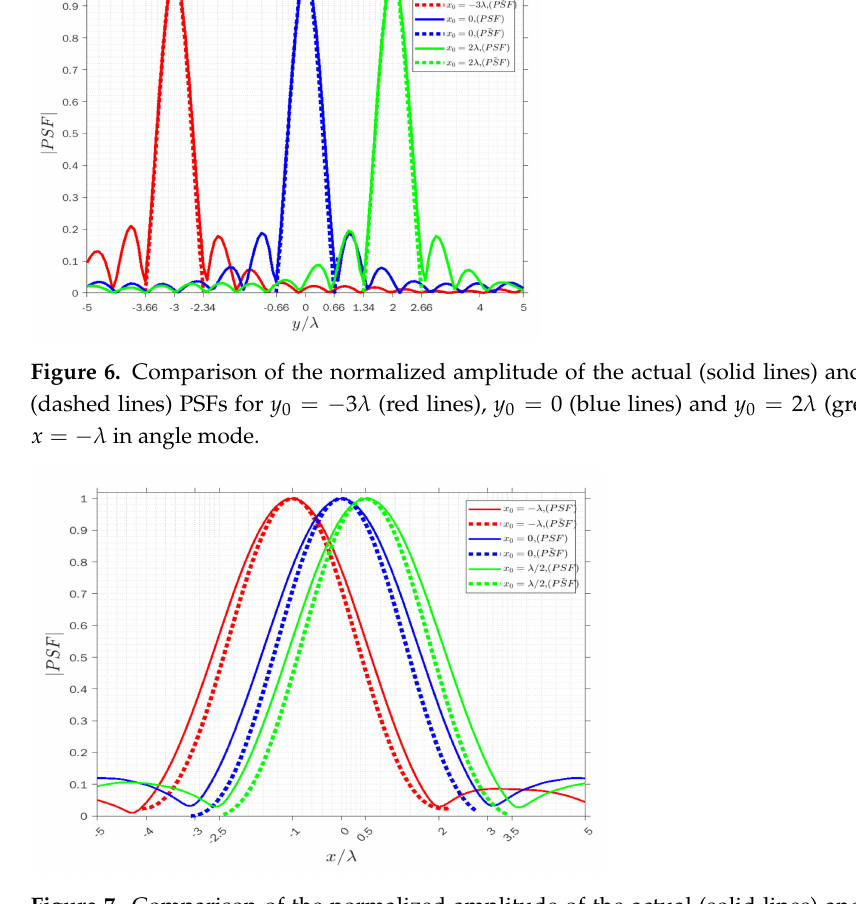
Figure 7. Comparison of the normalized amplitude of the actual (solid lines) and approximated (dashed lines) PSFs for x 0 = − λ (red lines), x 0 = 0 (blue lines) and x 0 = λ 2 (green lines) when y = 0 in receiving mode.